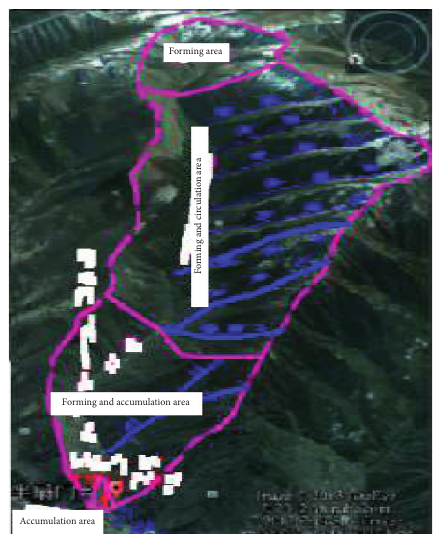
Figure 3: The whole picture about debris